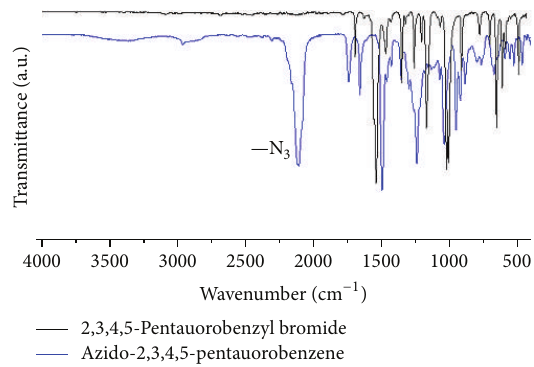
DMAP at room temperature [35]. The GPC analysis provided evidence for the success of reaction. As expected, there was a slight increase in the 𝑀 𝑛 values.